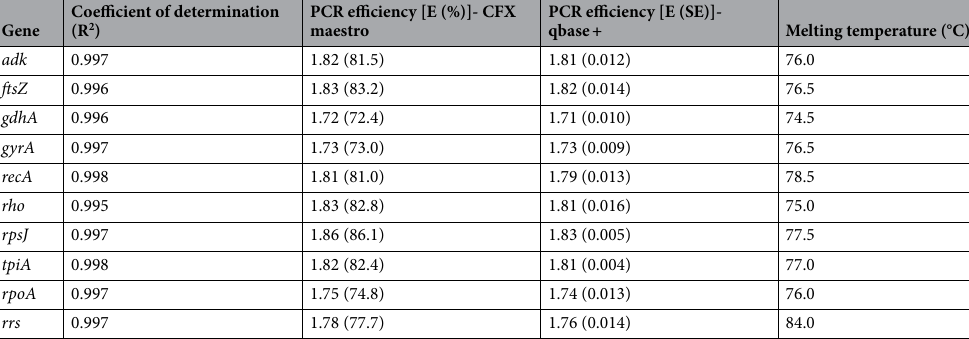
Table 2. Features of the candidate reference